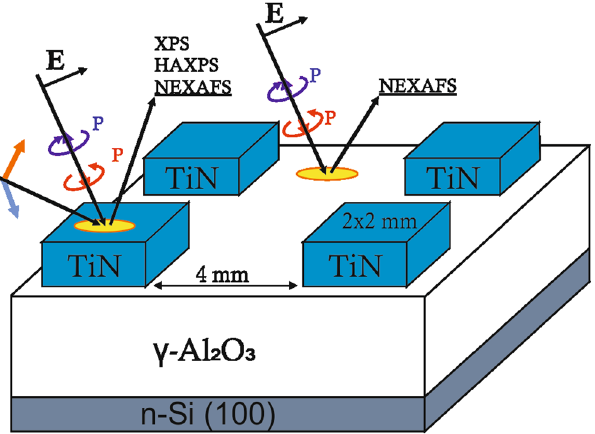
Figure 10. Schematic representation of TiN/ γ -Al 2 O 3 /Si sample after patterning TiN electrodes illustrating geometry of applying different measurement